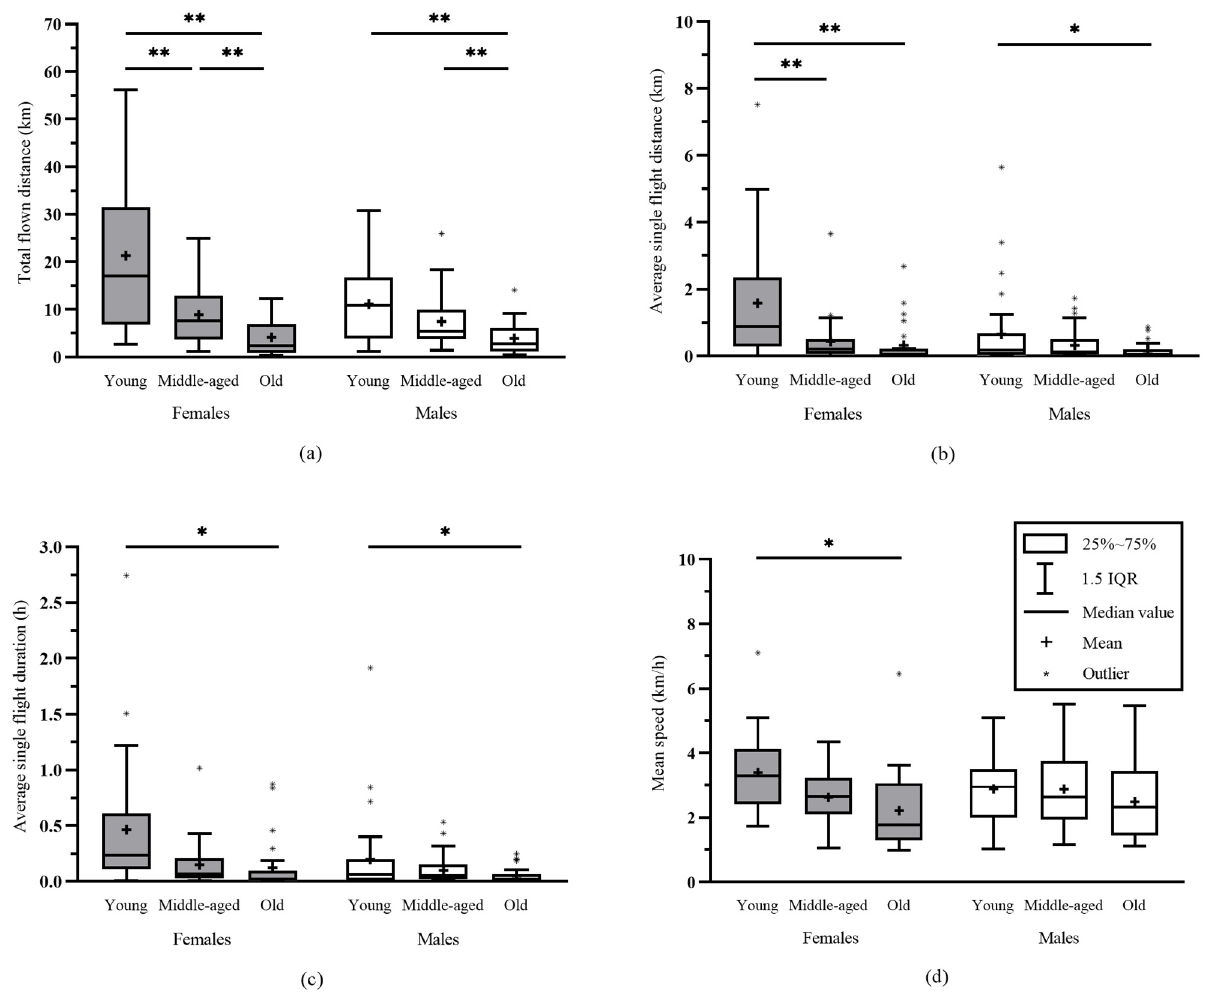
Figure 1. The flight capacity of Sirex noctilio for different PED ages. ( a ) Total flown distance of S. noctilio for different PED ages. ( b ) Average single-flight distance of S. noctilio for different PED ages. ( c ) Average single-flight duration of S. noctilio for different PED ages. ( d ) Mean speed of S. noctilio for different PED ages. * indicates a significant difference at p = 0.05; ** indicates a significant difference at p = 0.01.